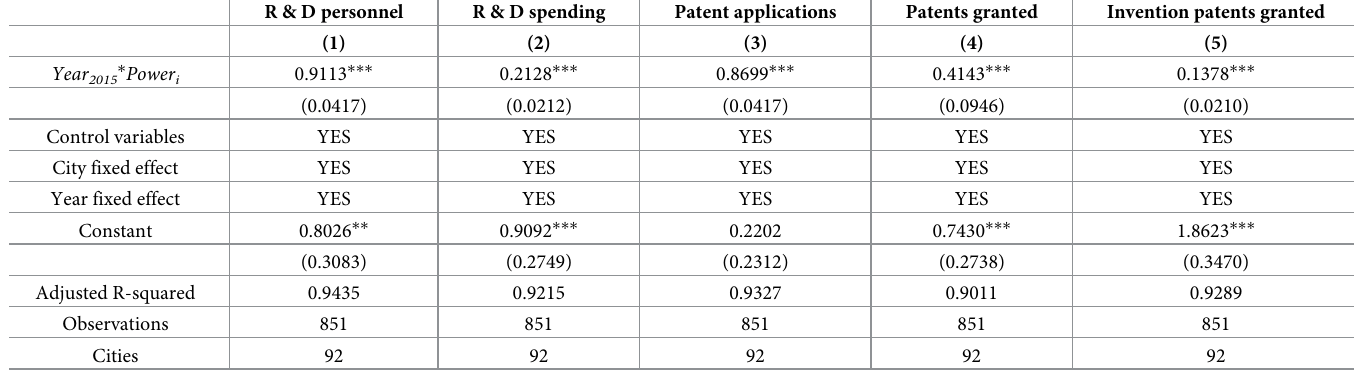
Table 9. The impact of power market reform on technological